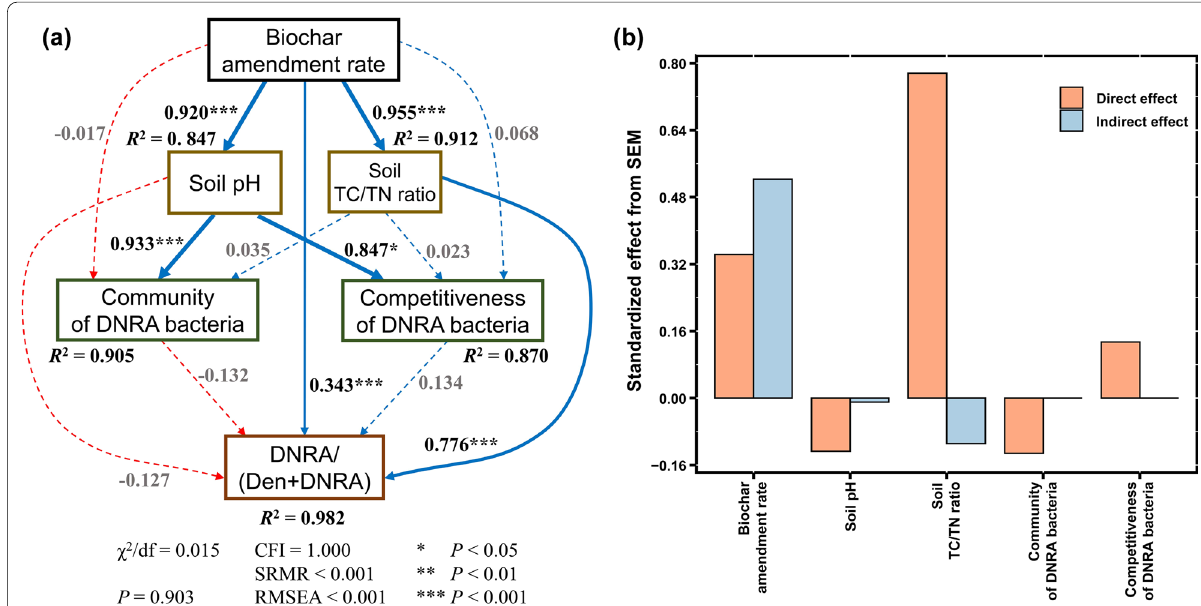
Fig. 7 Structural equation model based on the effects of abiotic (soil pH and TC/TN ratio) and biotic factors (community and competitiveness of nrfA -encoding DNRA bacteria) on the DNRA/(Den DNRA) ratio. The community of nrfA -encoding DNRA bacteria was represented by the + corresponding alpha diversity (i.e., Shannon index). Competitiveness means the coexclusion relationship that is represented by ratios of negative and positive correlations between DNRA bacteria and denitrifiers [ nrfA - nirK ( S ))]. Blue and red solid arrows indicate significant positive and negative relationships, respectively. The thickness of the arrows is directly proportional to the standardized path coefficient on the single arrow. R 2 represents the variance of factors explained by Model ( a ). Standardized effects (direct and indirect effects) derived from the structural equation model used ( b